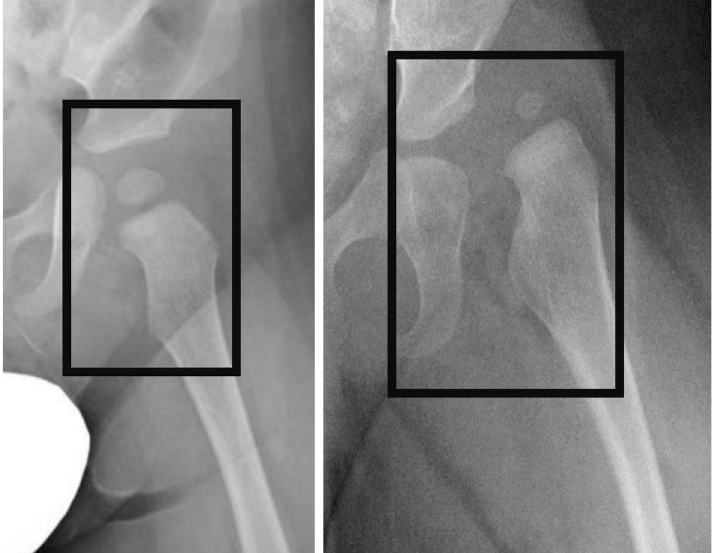
Figure 1. Annotation examples. Examples of bounding boxes for normal (left image) and DDH (right image) hips. DDH Developmental dysplasia of the hip.